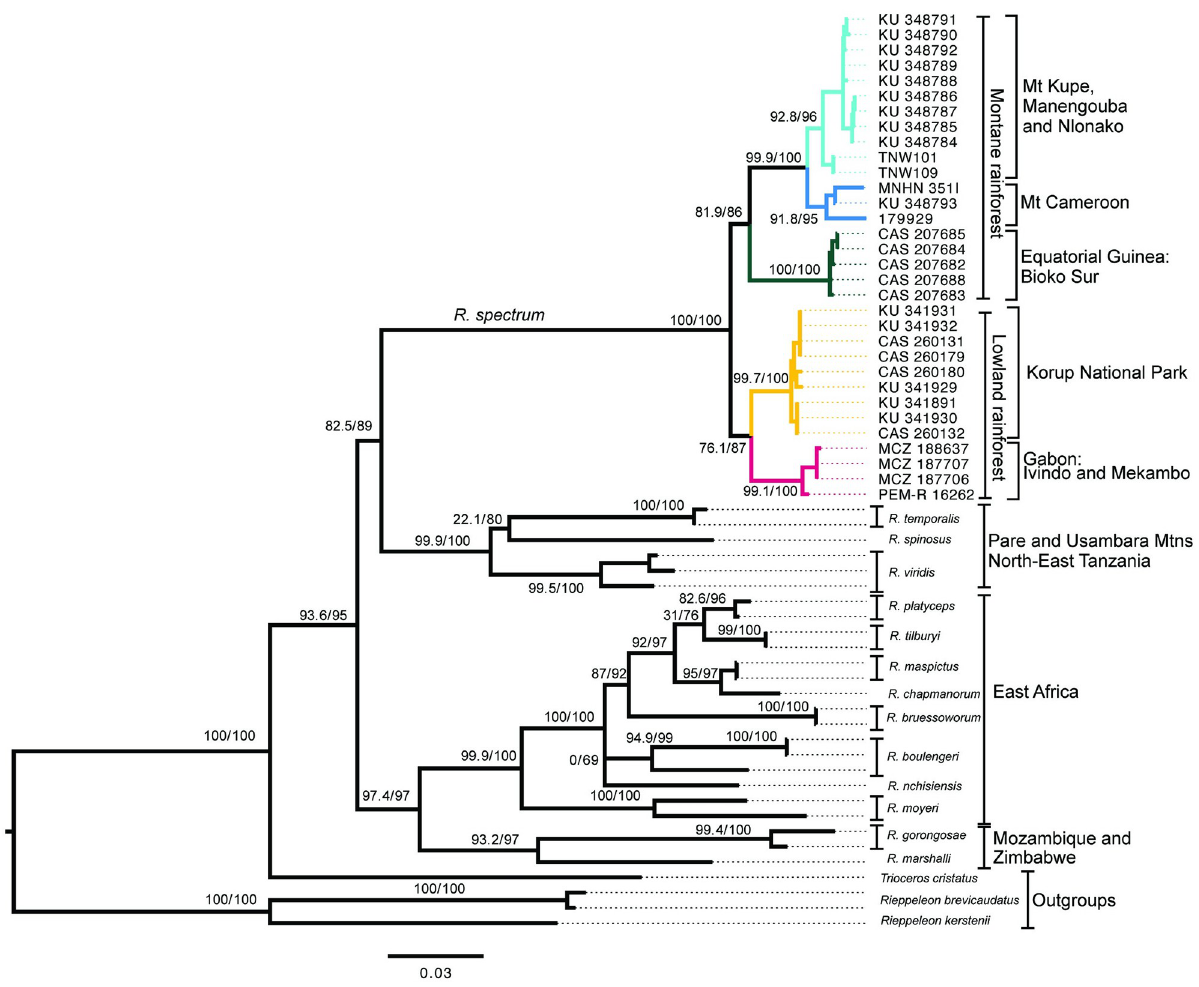
Fig 3. Maximum likelihood phylogenetic tree inferred from 16S + ND4 + RAG1 data set in IQ-TREE. Node values represent SH-aLRT/Ultrafast bootstrap supports in percentage. Branch colors correspond to key in Fig 2.